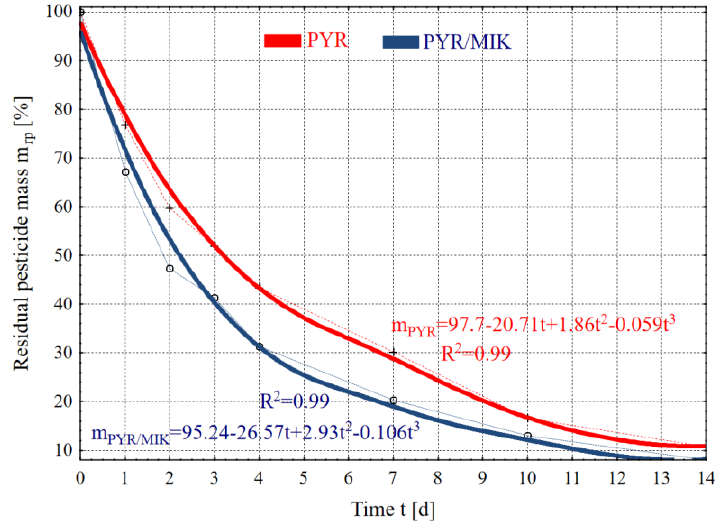
Figure 7. Mass deposition (% of residual PYR mass) in wastewater without microorganisms (PYR) and enriched with microorganisms (PYR/MIK) passed through a constructed wetland bed at 14